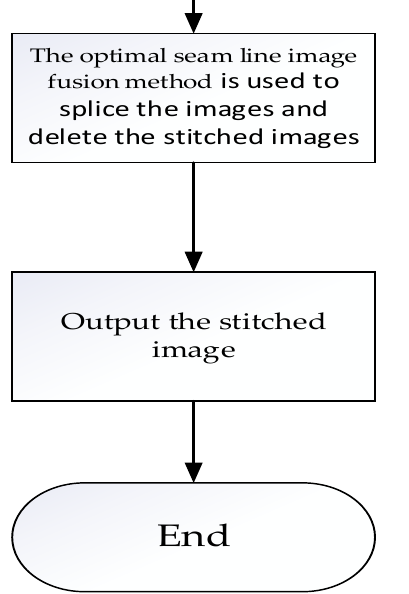
Figure 3. The flowchart of the MSIS method.